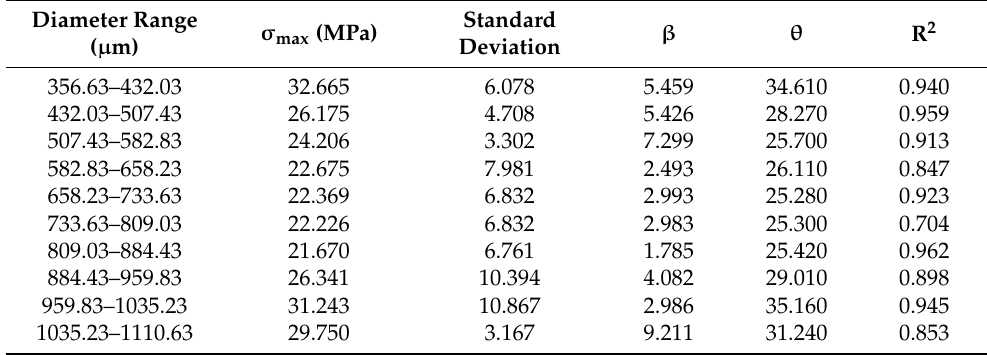
Table 5. Maximum tensile strength calculated for each diameter interval and Weibull parameters.